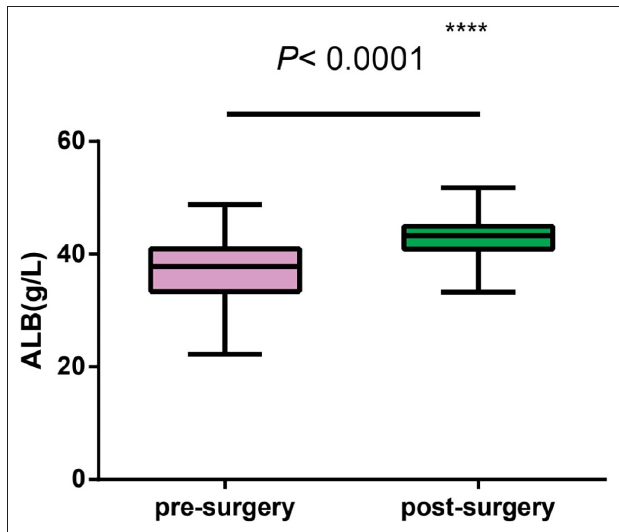
FIGURE 2 | Independent sample comparison statistics of pre- and post-operative blood albumin